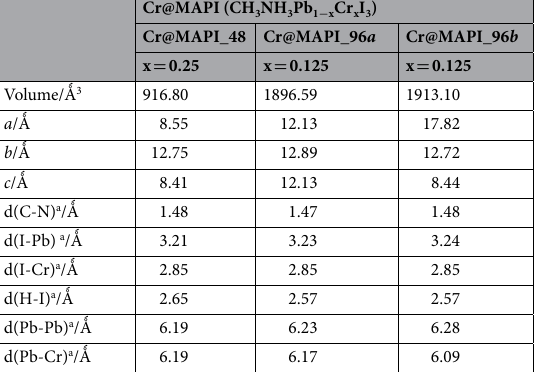
Table 2. Lattice parameters, bond distances and cell volumes obtained from optimized crystal structure of Cr- substituted MAPI perovskite (CH i.e . replicating lattice parameter a (Cr@MAPI_96 b , x = 0.125). a Average distances over each type of bonds